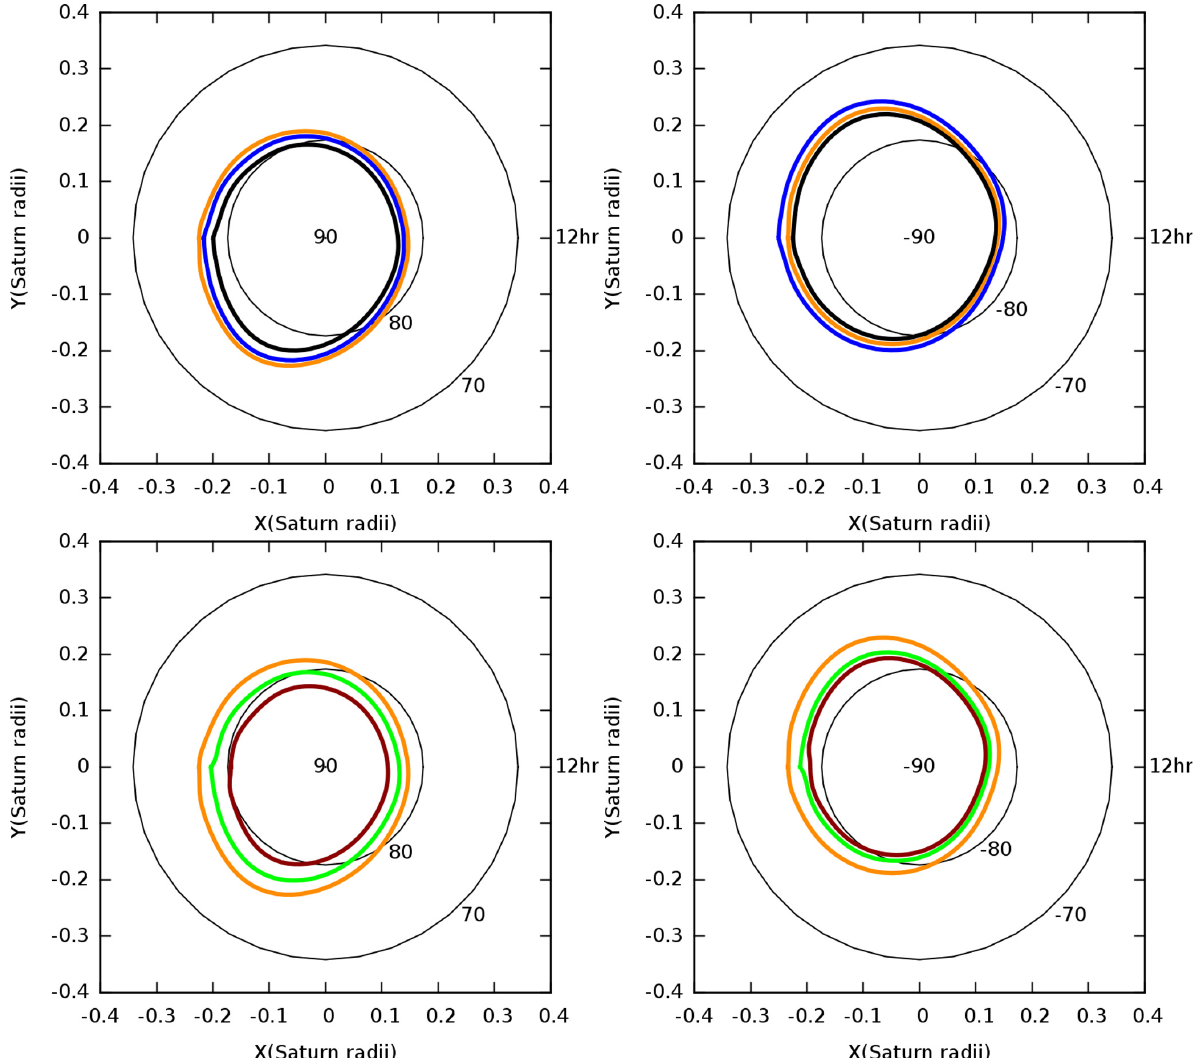
Fig. 4. Open field regions in Saturn’s northern (left) and southern (right) polar caps for various field and ionospheric surface models. (a) Orange (outer) oval marks the open flux boundary for the dipole field model and a spherical ionosphere. Blue (intermediate) oval marks the open flux boundary for the dipole plus quadrupole field and a spherical ionosphere. Black (inner) oval is for the open flux boundary for the multipole (dipole, quadrupole, octupole) field model and a spherical ionosphere. (b) The same for the southern polar cap except that now the oval for the dipole field and the spherical ionosphere (orange) is intermediate, the dipole plus quadrupole for the spherical ionosphere (blue) is the outer oval, and the multipole with spherical ionosphere (black) oval is the inner. (c) For northward hemisphere the orange outer oval marks the open flux boundary for the dipole field and spherical ionosphere model, while the green intermediate oval marks the open flux boundary for the dipole field and a spheroidal ionosphere, and the brown inner oval is the open flux boundary for the multipole (dipole, quadrupole, octupole) field and spheroidal ionosphere model. (d) The same for the southern polar cap.